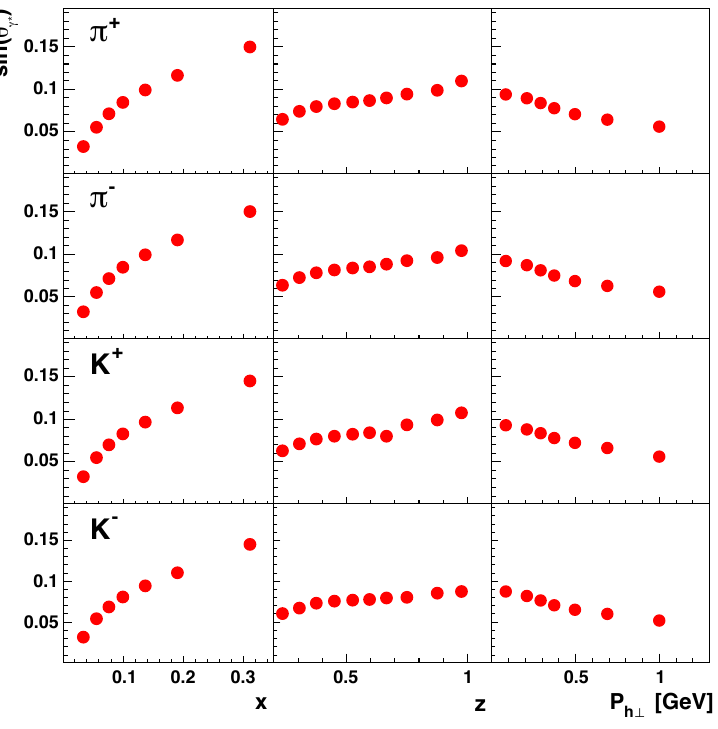
Figure 39 . Average sin θ γ ∗ as a function of x , z , or P h ⊥ for charged mesons as